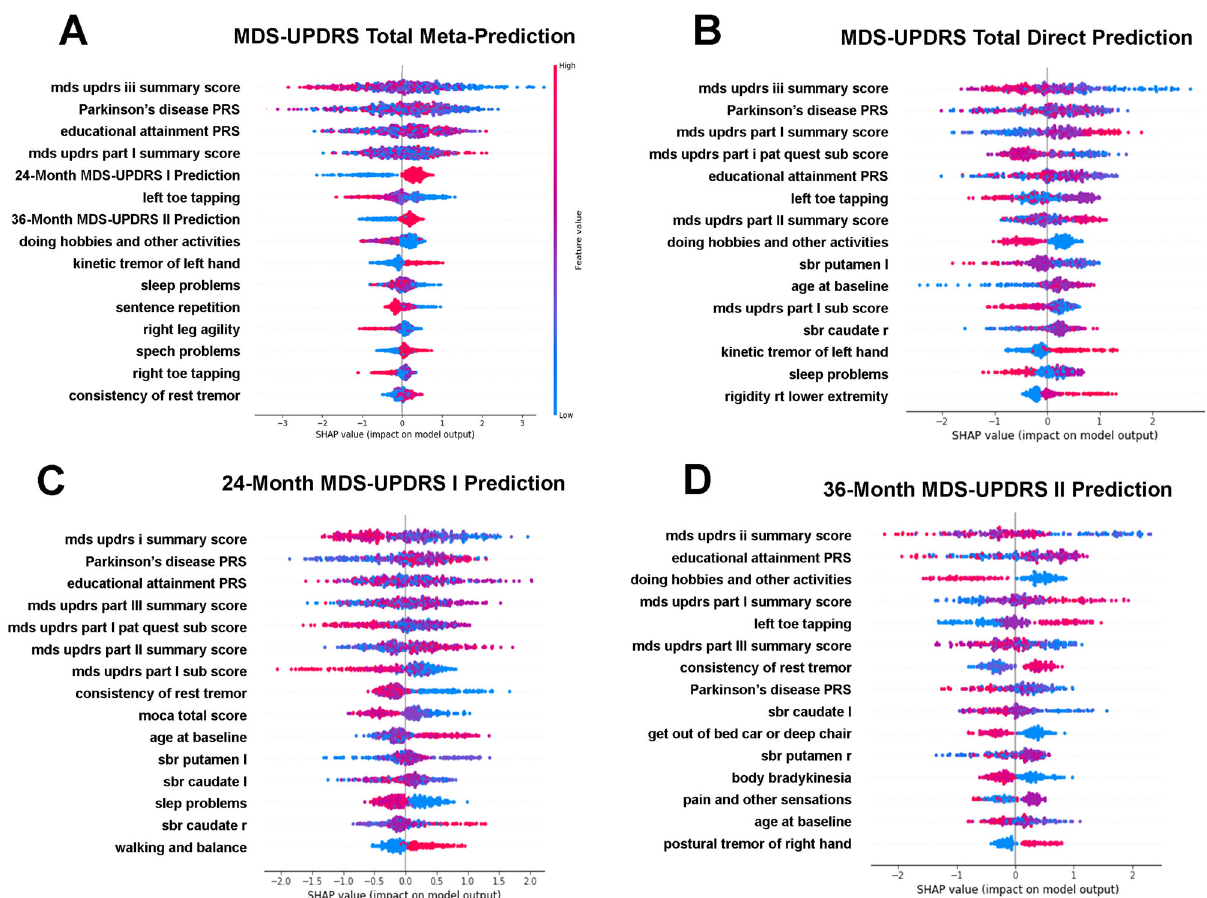
Fig. 3 12-month MDS-UPDRS total meta-predictor feature importance. Shapley feature importance plots for direct ( B ) and meta-prediction ( A ) of 12-month MDS-UPDRS Total progression prediction. Shapley plots for important meta-features for meta-prediction of 12-month MDS- UPDRS Total progression status are shown in C 24-month MDS-UPDRS I prediction, and D 36-month MDS-UPDRS II prediction. Features are ranked for most to least important (top to bottom). Coloration depicts the value for each feature (red = high values, purple = average values, blue = low values). The impact on prediction at the individual-level is indicated by the points, where points to the right indicate increased importance for the prediction of progressor status, and points to the left indicate increased importance for the prediction of non-progressor